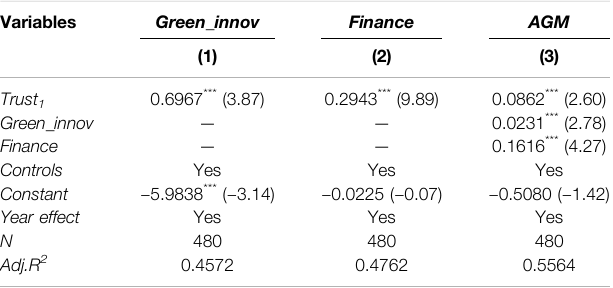
TABLE 8 | Mechanism tests: the role of regional green innovation and fi nance development.